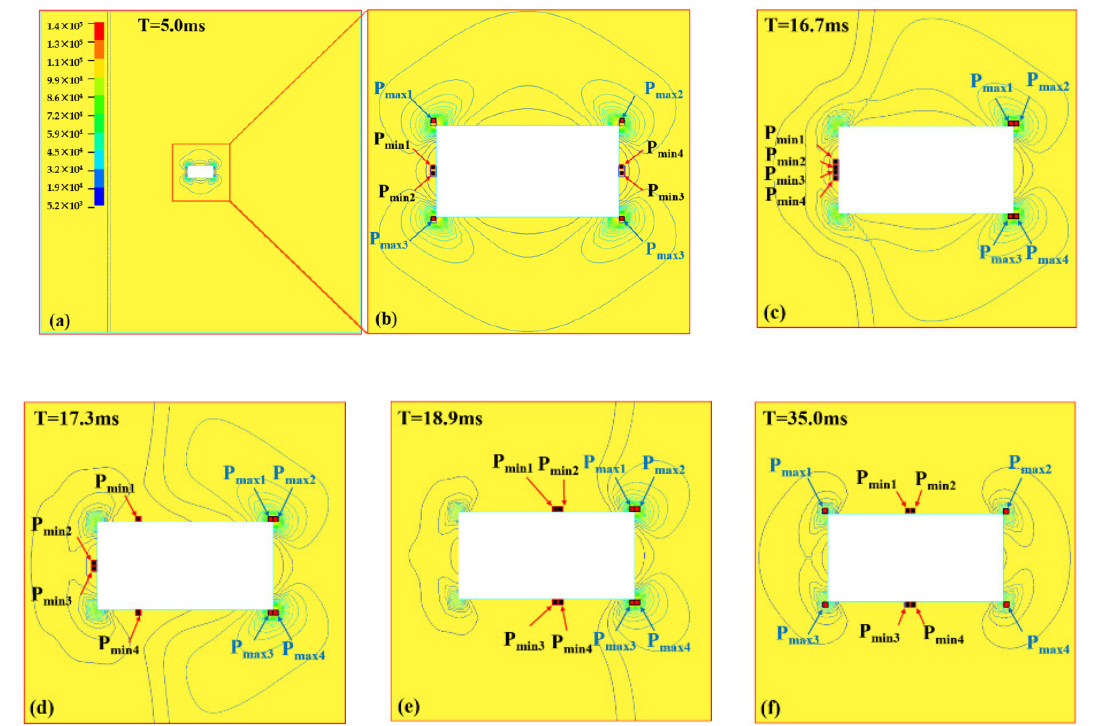
Figure 10. Contour lines of SED (model II). Note: units are in J / m 3 . ( a ) T = 5.0 ms; ( b ) a local enlarged view; ( c ) T = 16.7 ms; ( d ) T = 17.3 ms; ( e ) T = 18.9 ms; ( f ) T = 35.0 ms